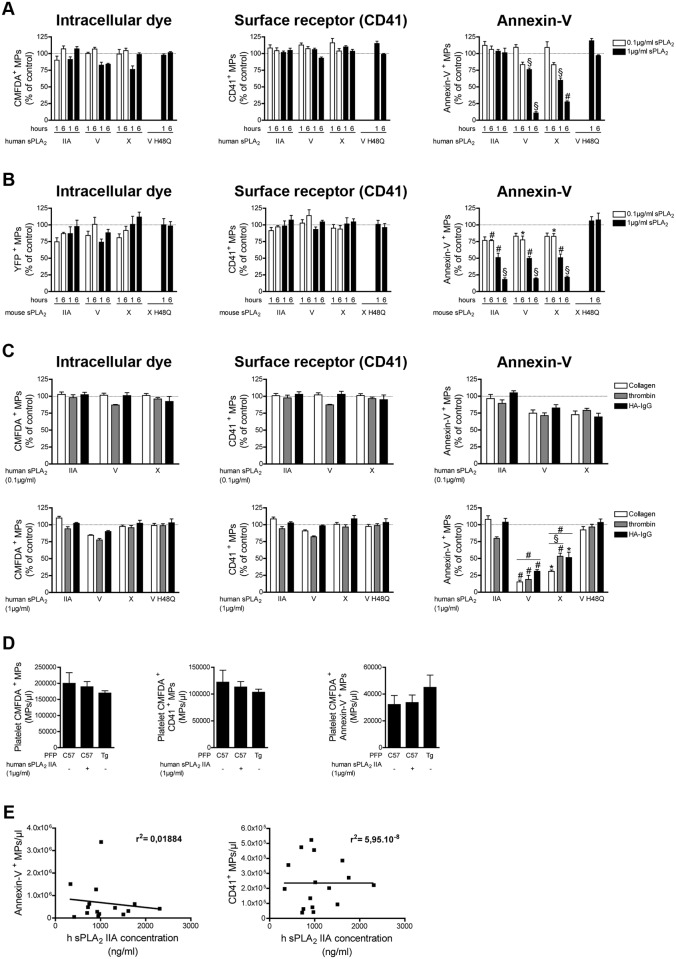
Impact of human and mouse sPLA2s on platelet MPs.(A) MPs from human platelets (stimulated with collagen) labeled with the CMFDA cell tracker were incubated for 1 and 6 hours at 37°c in absence or in presence of indicated concentrations of human recombinant sPLA2 IIA, V, X, or 1µg/ml of the inactive mutant V H48Q. Fluorochrome-conjugated antibodies directed against CD41 and fluorochrome-conjugated annexin-V were used to assess the quantities of CMFDA+ MPs (left panel), of CD41+ MPs (middle panel), of annexin-V+ MPs (right panel) and were compared to the untreated conditions (dotted line). Data are mean ± SEM of 5 independent experiments presented as % of untreated (control) (B) MPs from mouse platelets (stimulated with collagen), identified using YFP as fluorescent tracker, were incubated 1 and 6 hours at 37°c, in absence or in presence of indicated concentrations of mouse recombinant sPLA2 IIA, V, X, or 1µg/ml of the inactive mutant X H48Q. Fluorochrome-conjugated antibodies directed against CD41 and fluorochrome-conjugated annexin-V were used to determine the concentrations of YFP+ MPs (left panel), of CD41+ MPs (middle panel), of annexin-V+ MPs (right panel) and then compared to the untreated conditions (dotted line). Data are mean ± SEM of 5 independent experiments presented as % of untreated (control). (C) MPs from human platelets labeled with the CMFDA cell tracker and obtained following stimulation with collagen, thrombin or HA-IgG were incubated 6 hours at 37°c in absence or in presence of indicated concentration of human recombinant sPLA2 IIA, V and X and 1µg/ml of the inactive mutant sPLA2 V H48Q. Fluorochrome-conjugated antibodies directed against CD41 and fluorochrome-conjugated annexin-V were used to assess the quantities of CMFDA+ MPs (left panel), of CD41+ MPs (middle panel), of annexin-V+ MPs (right panel) and then compared to the untreated conditions (dotted line). Data are mean ± SEM of 3 independent experiments presented as % of untreated (control). (D) MPs from human platelets (stimulated with collagen) labeled with the CMFDA cell tracker were incubated 6 hours at 37°c in PFP of C57BL6 (supplemented or not with 1µg/ml of recombinant human sPLA2 IIA) or transgenic mice expressing the human sPLA2 IIA (Tg). Fluorochrome-conjugated antibodies directed against CD41 and fluorochrome-conjugated annexin-V were used to assess the quantities of CMFDA+ MPs (left panel), of CMFDA+ CD41+ MPs (middle panel) and CMFDA+ annexin-V+ MPs (right panel). Data are mean ± SEM of 3 independent experiments. (E) Concentrations of Annexin-V+ MPs and CD41+ MPs present in the synovial fluids of RA patients determined by high sensitivity flow cytometry and correlated to the concentration of human sPLA2 IIA assayed (in the same synovial fluids) by time-resolved immunofluorescence analysis. * P< .05; # P< .01; § P< .001.